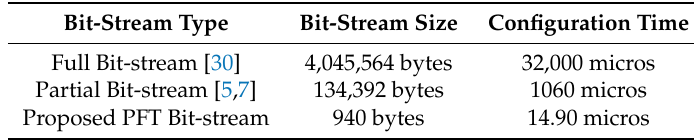
Table 7. Configuration Time Comparison for XC7020